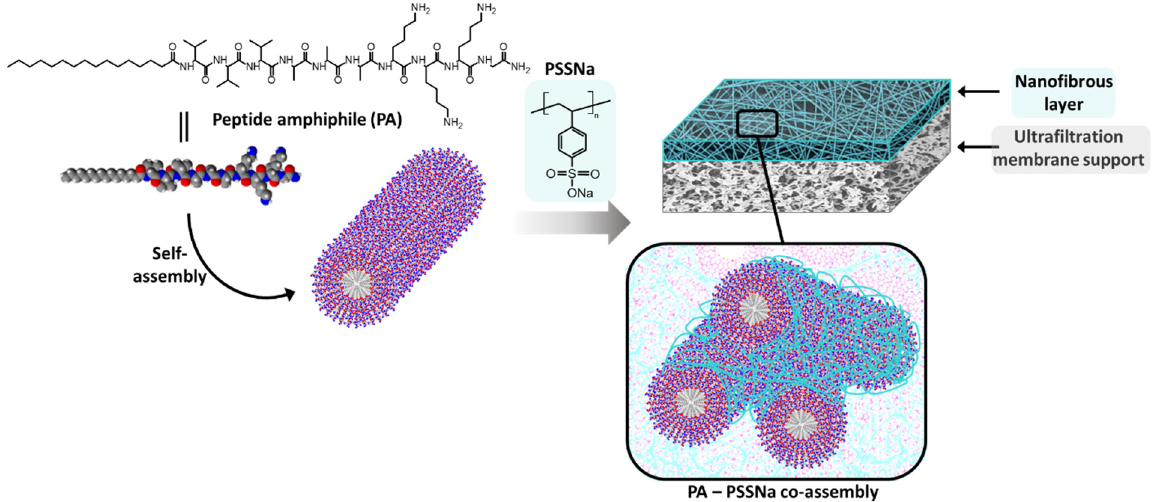
Figure 1. Schematic representation of a nanofibrous membrane from peptide amphiphile C 16 V 3 A 3 K 3 G-NH 2 and poly(sodium 4-styrenesulfonate) (PSSNa) co-assembly.